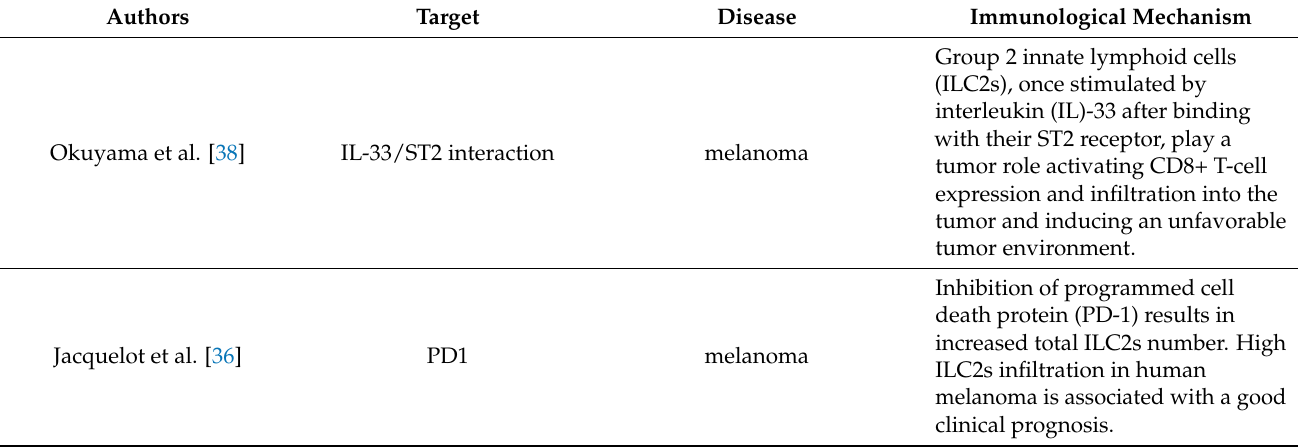
Table 4. The main finding about the potential therapeutic role of ILC2s in melanoma, AD and cutaneous type 2